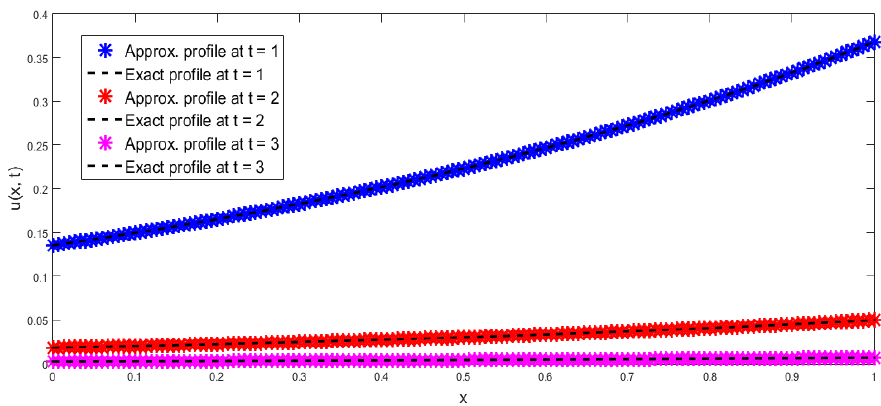
Figure 5. Comparison of approx. and exact profiles at t = 1, 2, 3 regarding Example 5.